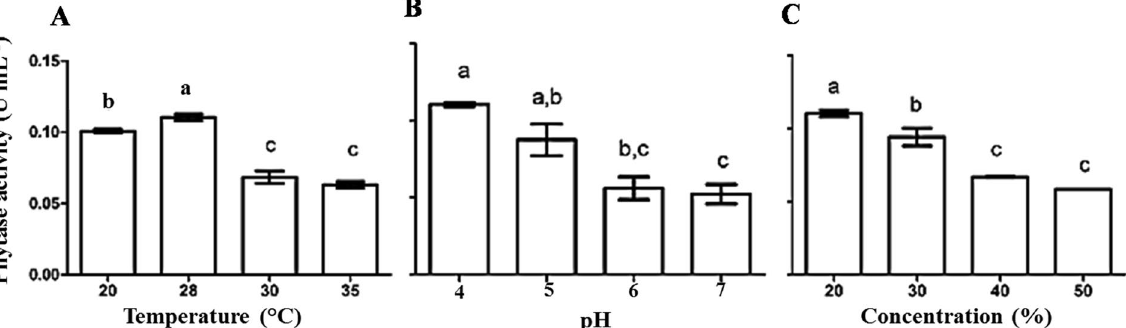
Figure 4. Phytase production by Acremonium zeae B via solid state fermentation under different conditions of temperature ( A ), pH ( B ) and substrate concentration ( C ). The fixed parameters for each experiment were, when applicable, temperature of 28 °C, pH 4.0 and 10% (m/v) of corn meal. The bars correspond to the standard deviations of the means (n = 3). Equal letters do not differ at 95% confidence by the Tukey test.